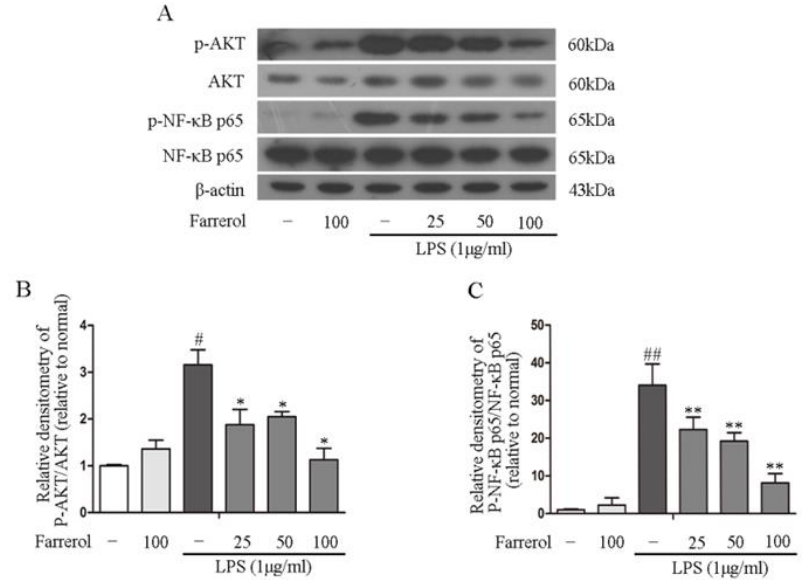
Figure 6. NF- κB p65 and AKT phosphorylation were downregulated by Farrerol in LPS-stimulated RAW264.7 cells. Pretreating cells with different concentrations of Farrerol (25, 50, and 100 μM) for 1 h, then cells were stimulated with LPS (1 μg/m L) for 1 h. The phosphorylation and total forms of NF- κB p65 and AKT were examined by western blot ( A ). The phosphorylation ratio of NF- κB p65 and AKT were quantified ( B , C ) ( n = 3). # p < 0.05 and ## p < 0.01 compared to the control group, * p < 0.05 and ** p < 0.01 compared to the LPS group, and statistical significance was determined by ANOVA.